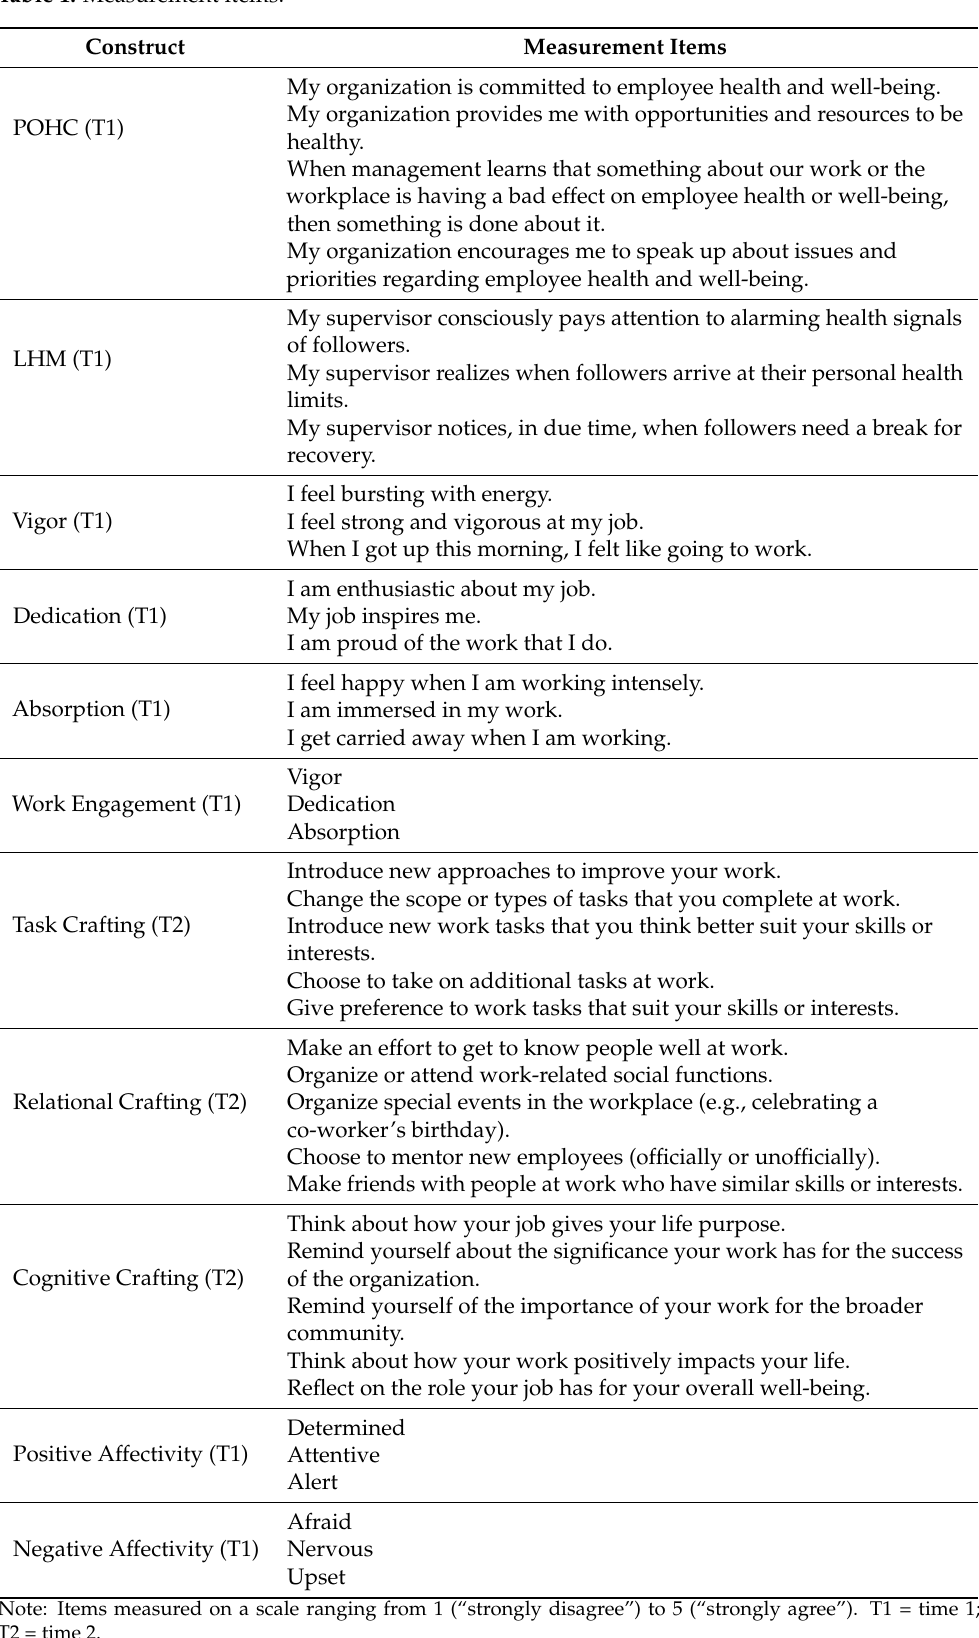
Table 1. Measurement